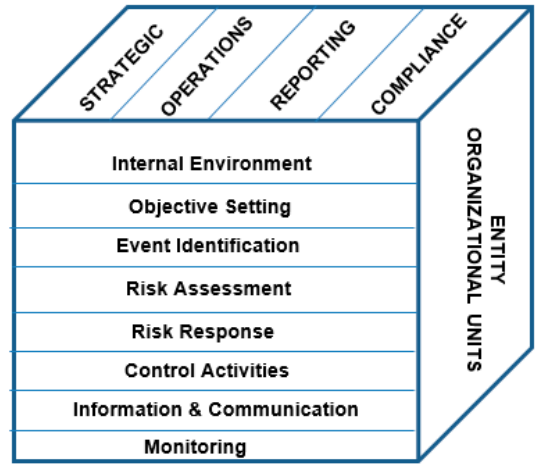
Figure 2. ERM-Integrated Framework from COSO. Source: author own study based on COSO (2004).